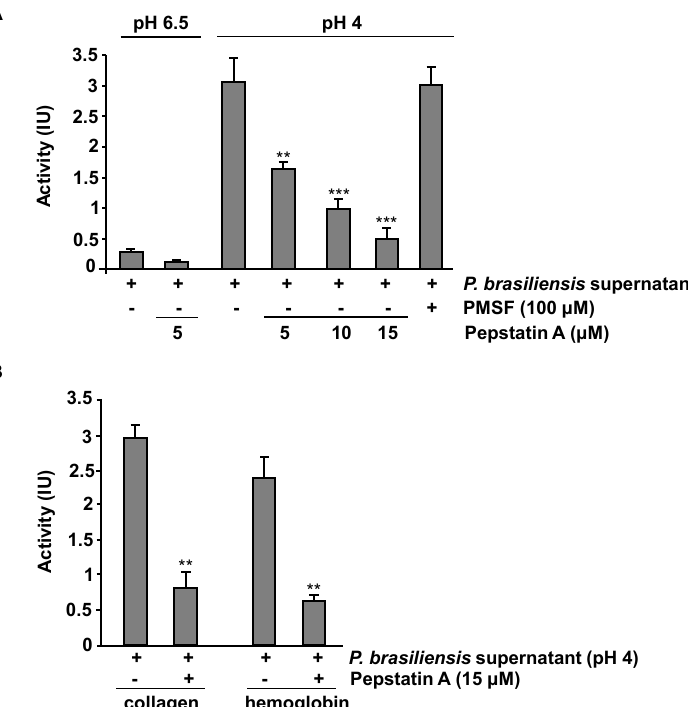
Figure 6. Proteolytic activity profile of secreted acid proteases from P. brasiliensis . ( A )Yeast cells were grown in YPDm with a pH of 6.5 or 4 for five days. Proteolytic activity was measured using 20 µL of sample (cell-free supernatant) and 80 µL of 7.5 µM bovine serum albumin (BSA) in 0.1 M citric acid/sodium phosphate, with a pH of 3.3, and incubated at 50 °C. Samples were incubated in the presence or absence of Pepstatin A (5, 10, and 15 µM) or PMSF (100 µM). Then, 20 µL were removed after 30 min and added to 180 µL of Coomassie PlusTM protein assay reagent (Pierce) in a microtiter plate. Absorbance was read at 590 nm, and activity (IU) was calculated relative to BSA degradation using a standard curve. One IU is de fi ned as the degradation of 1 µmol of BSA min − 1 .mL − 1 . ( B ) Samples were incubated with collagen or hemoglobin for 30 min in the presence or absence of Pepstatin A. ** p ≤ 0.01, and *** p ≤ 0.001. The results shown are representative of three independent experiments.